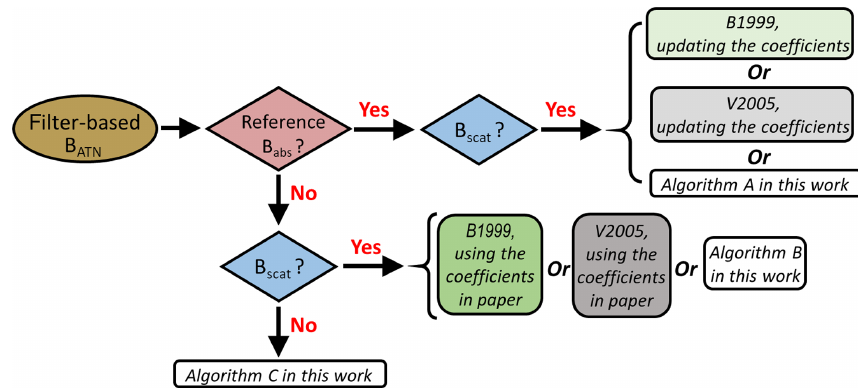
Figure 1. The flowchart for the application of correction algorithms on PSAP, CLAP, and TAP. Similar logic is followed for the AETH. Table 3. Relationship between the CLAP-derived B abs corrected by the B1999 and V2005 algorithms (including updated coefficients) and the reference B abs at 652, 528, and 467nm. The relationship is achieved using major axis regression (Ayers, 2001). The value in parentheses represents the coefficient of determination ( R 2 ) of the linear